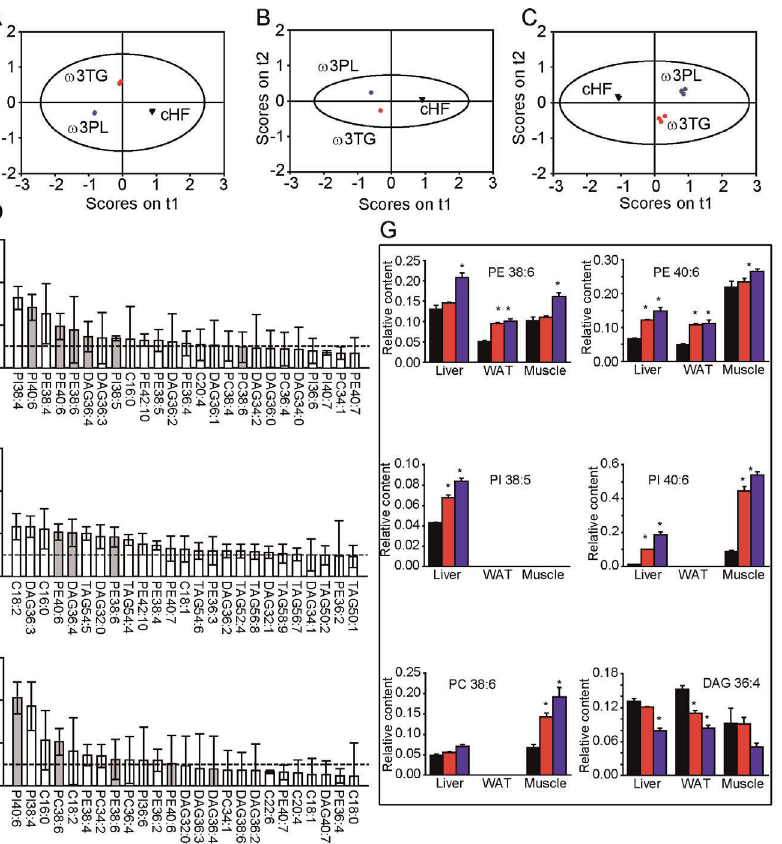
Figure 3. Changes in the lipid spectra in response to dietary LC n -3 PUFA in selected tissues of mice in the ‘prevention study’. Mice were fed for 9 weeks the cHF (black triangles), cHF + v 3TG (red circles), or cHF + v 3PL (blue circles) diet, while the last two diets were supplemented with 30 g DHA/EPA per kg. In total, 59, 71 and 61 lipid species were quantified in the liver, epididymal WAT and skeletal muscle, respectively, using time-of-flight secondary ion mass spectrometry ( TOF-SIMS ) analysis (see also Table S8, S9, S10). Means 6 SEM of 3–6 TOF-SIMS spectra from 3 animals per each group were used for orthogonal partial least squares-discriminant analysis ( oPLS-DA ). Score plots of the liver ( A ), WAT ( B ) and skeletal muscle ( C ) and corresponding variable important to projection (VIP) plots for the first latent variable ( D, E, F ), respectively. Only variables with VIP scores greater than 1 (denoted by a dashed horizontal line; D-F ) and narrow confidence intervals were used for further evaluations, and only those discriminating between cHF + v 3TG and cHF + v 3PL diets (gray bars, D-F ) were plotted (G; cHF diet, black bars; cHF + v 3TG diet, red bars; cHF + v 3PL diet; blue bars). See also Fig. S3 for additional lipid species identified. DAG, diacylglycerol. *Significantly different from cHF (all analyses by